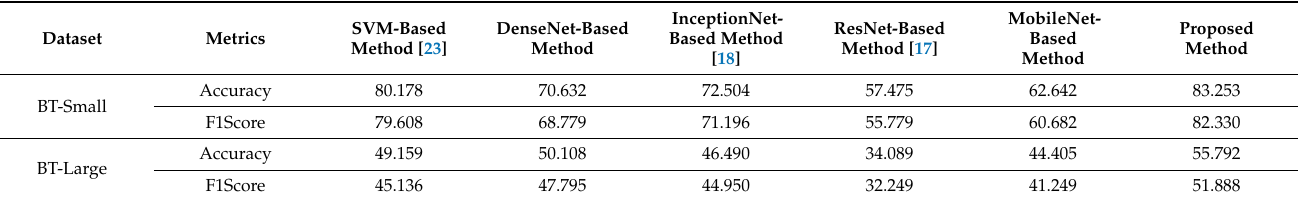
Table 13. Comparison on the classification performance (accuracy and F1Score) between the proposed method and previous studies (unit: